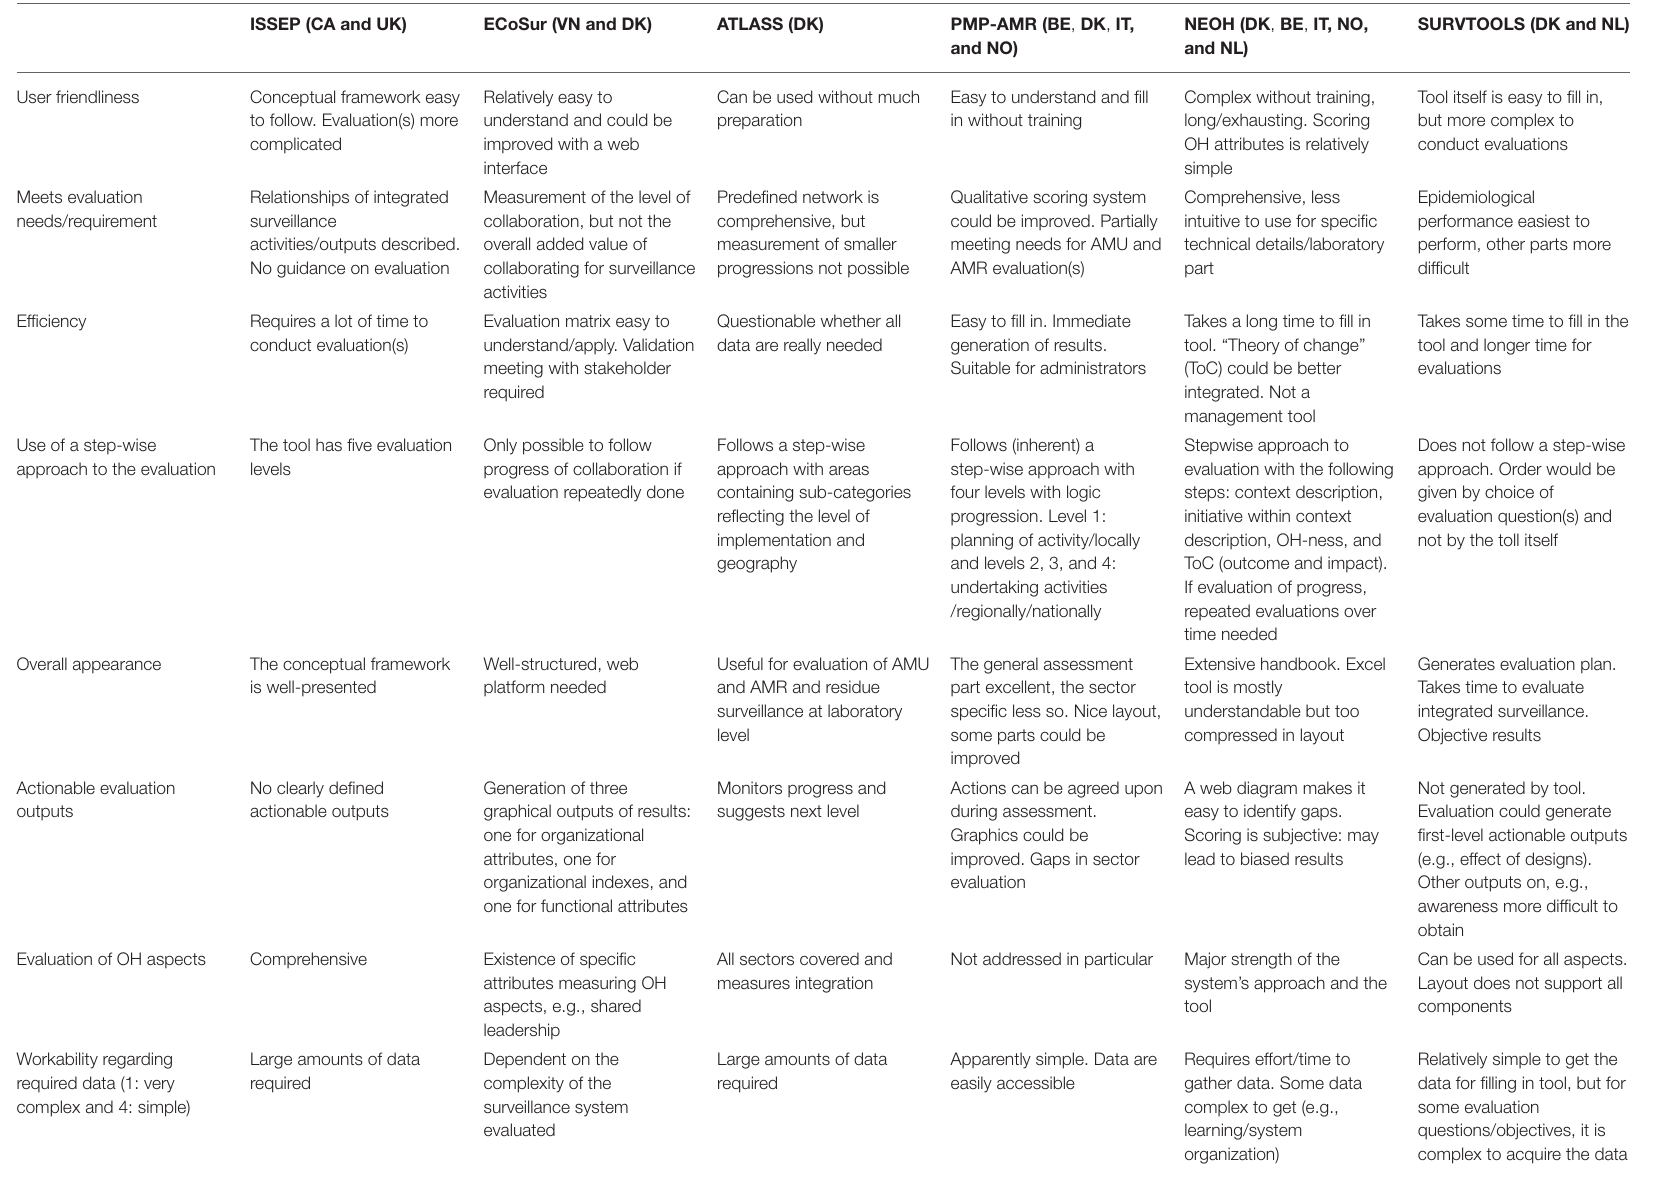
TABLE 4 | Results of synthesis of the underlying reasoning for the scoring according to the 11 functional aspects.